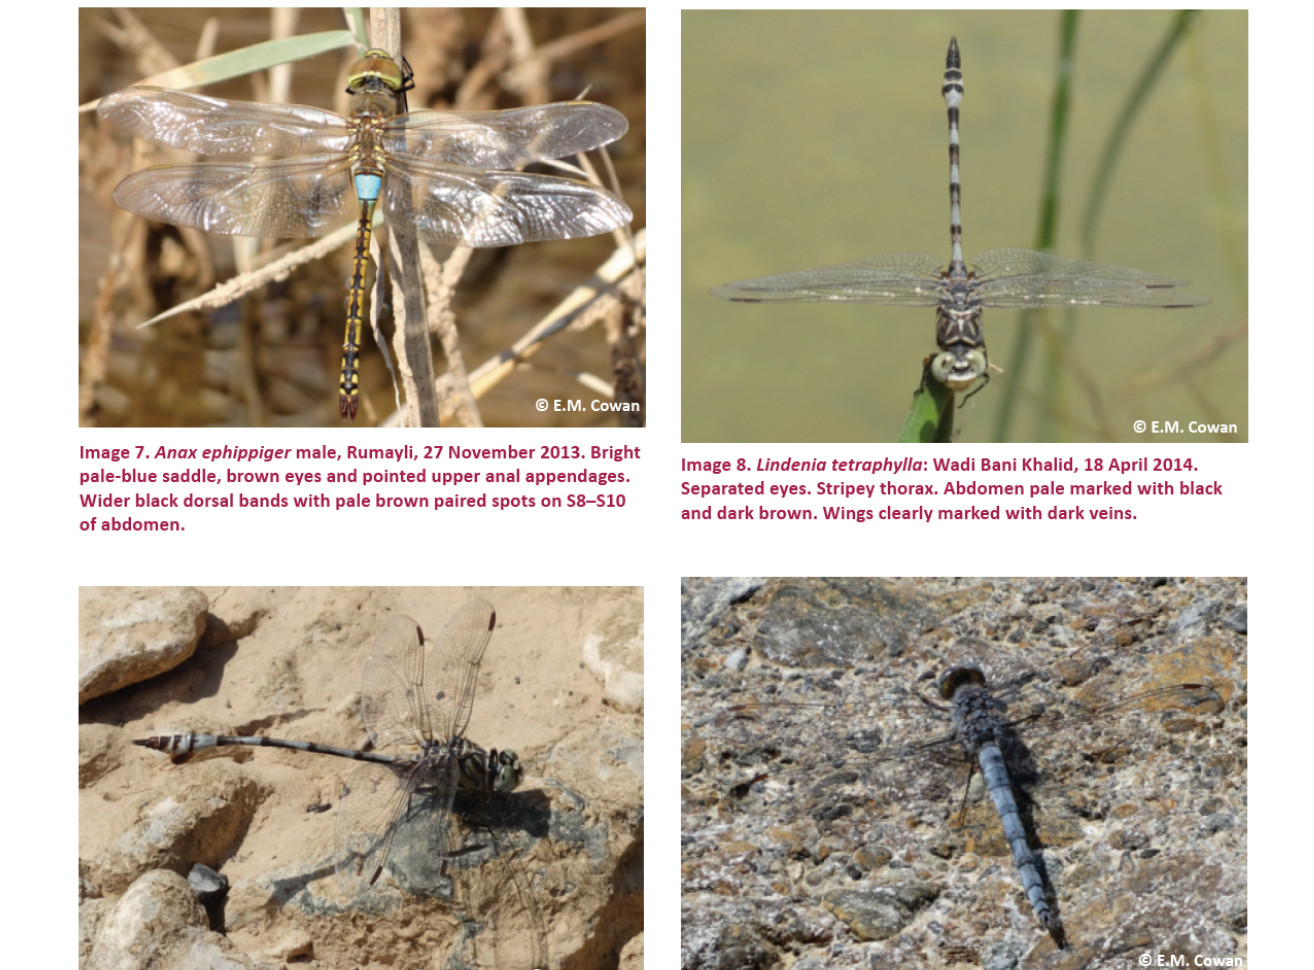
Image 10. Orftheftrum ransonnefifi: mafle, Wadfi Ahfin, 21 February 2014. Sftrafighft unwafisfted abdomen. Hfind wfing bases cflear. Phofto under magnfificafion shows bflack anftenodafl subcrossvefins and upper parft of eyes brown.